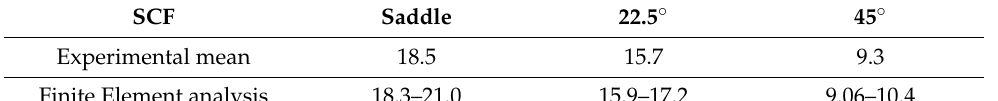
Figure 17. Present experimental mean SCF values against parametric Efthymiou, previous experimental work and FE based SCF values.